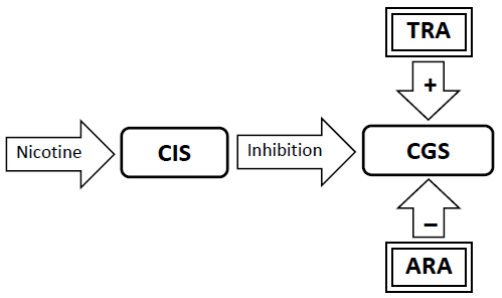
Figure 9. When an ex-smoker lapses and smokes a cigarette, nicotine stimulates the Craving Inhibition System (CIS) which delivers super-physiologic inhibition to the Craving Generation System (CGS), once again disrupting homeostasis in the CGS. The Abstinence-Related Adaptations (ARA) that provide inhibition to the CGS are now adding to the disruption of homeostasis rather than restoring it. The ARA are rapidly dismantled.